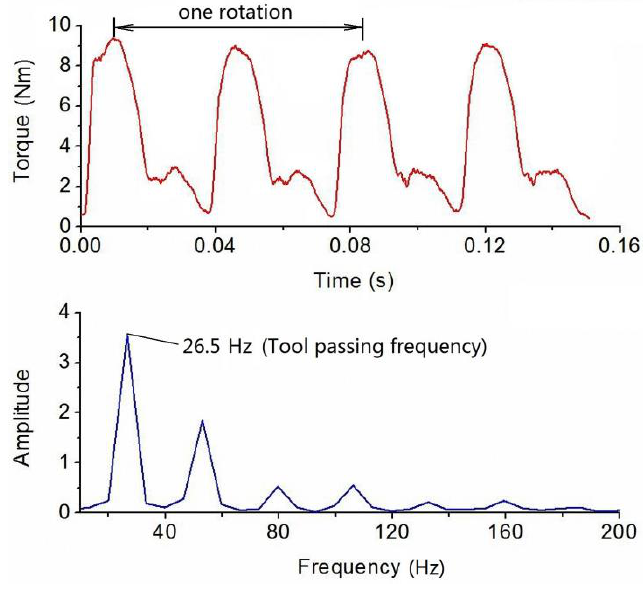
Figure 15. Plots of torque force signals in time and frequency domain at a spindle speed of 800 rpm.